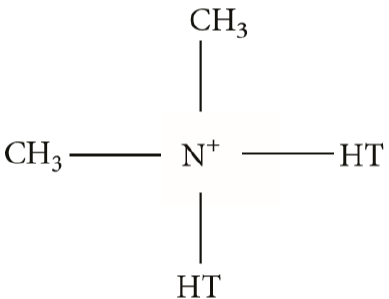
Figure 2. Molecular structure of Cloisite-15A modifier. Reproduced with permission from the authors of